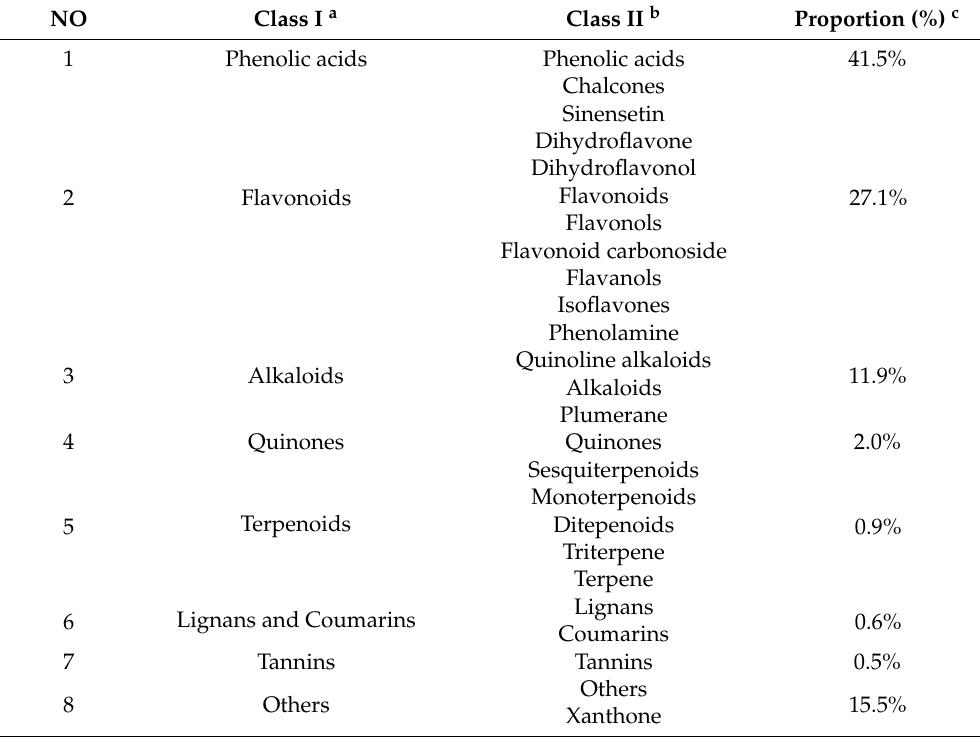
Table 1. The principal compounds and sub-compounds of ginger shoot extract (GSE) were identified by LC-MS/MS, and their contents were determined by relative